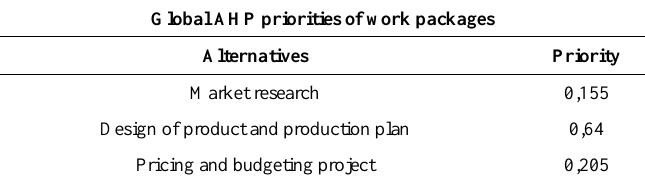
Figure 8. AHP model of work package prioritization problem. Table 8. Global AHP priorities of work packages.